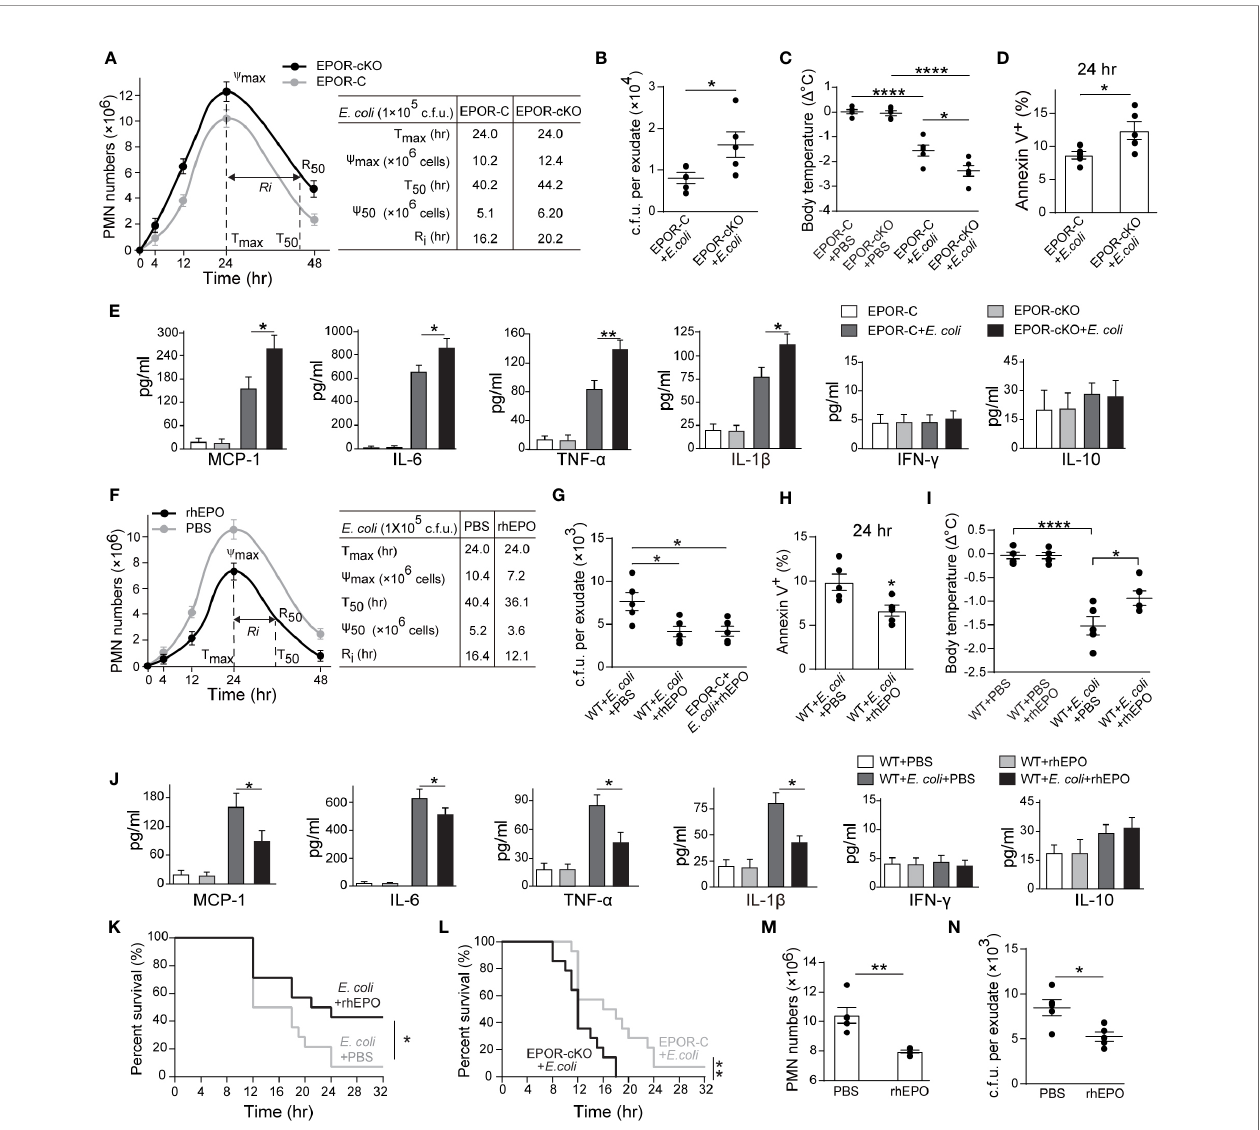
FIGURE 2 | Macrophage EPO signalingregulates resolution of E. coli -initiatedinfections. For (A – E) , EPO-C, andEPOR-cKO mice were inoculatedwith 1 × 10 5 c.f.u. E. coli (n = 5 for each group ateach time point), (A) Time course ofperitoneal PMN numbersand resolution indices (n = 5). (B) : Bacterial titersof peritoneal lavage fl uids at 24 hrs (n = 5). (C) Changes in body temperatures expressed as mean of D °C(temperature at24 h – temperature at 0 h,n = 5). (D) Percentage of apoptoticperitonealleukocytes at 24 h (n = 5). (E) In fl ammatory cytokines inperitoneallavage fl uidsat 24 h (n = 3).For (F – J) , WTmice were inoculated with 1 × 10 5 c.f.u. E.coli (n= 5 for each group at each time point) together with rhEPO (5,000 IU/kg)orPBS. (F) Timecourse of peritoneal PMNnumbersand resolution indices (n= 5). (G) Bacterial titersofperitoneal lavage fl uids at 24 hrs (n= 5). (H) Percentage of apoptotic peritoneal leukocytes at 24 hrs (n= 5). (I) Changes in body temperatures of (n = 5). (J) In fl ammatory cytokines in peritoneal lavage fl uids at 24 hrs (n= 3). (K) Percent survivalof E. coli (5× 10 7 c.f.u.) inoculated WTmice alone orwith 5,000 IU/kg of rhEPO (n= 14 for each group). (L) Percent survival of E.coli (5 × 10 7 c.f.u.) inoculated EPO-C and EPOR-cKOmice (n = 14 for each group).For M-N, WTmice were inoculatedwith 1 × 10 5 c.f.u. E. coli , 12 hoursafter infection,mice were treatedwith rhEPO (5,000 IU/kg) or PBS (n= 5 for each group),and 12 hours after rhEPO treatment, mice were sacri fi ced for measurement. (M) Peritoneal PMN numbers(n= 5). (N) Bacterial titersof peritoneal lavage fl uids(n= 5). Data are representative of at least two independent experiments. Results were expressed as mean ± SEM.* P < 0.05, ** P < 0.01, and **** P < 0.0001. Statistics: unpaired two-tailed Student ’ s t-test (B, D, H, M, N) , one-way ANOVA with Tukey ’ s post hoc testfor multiplecomparisons (C,E,G,I, J) orLog-Rank test (K,L)